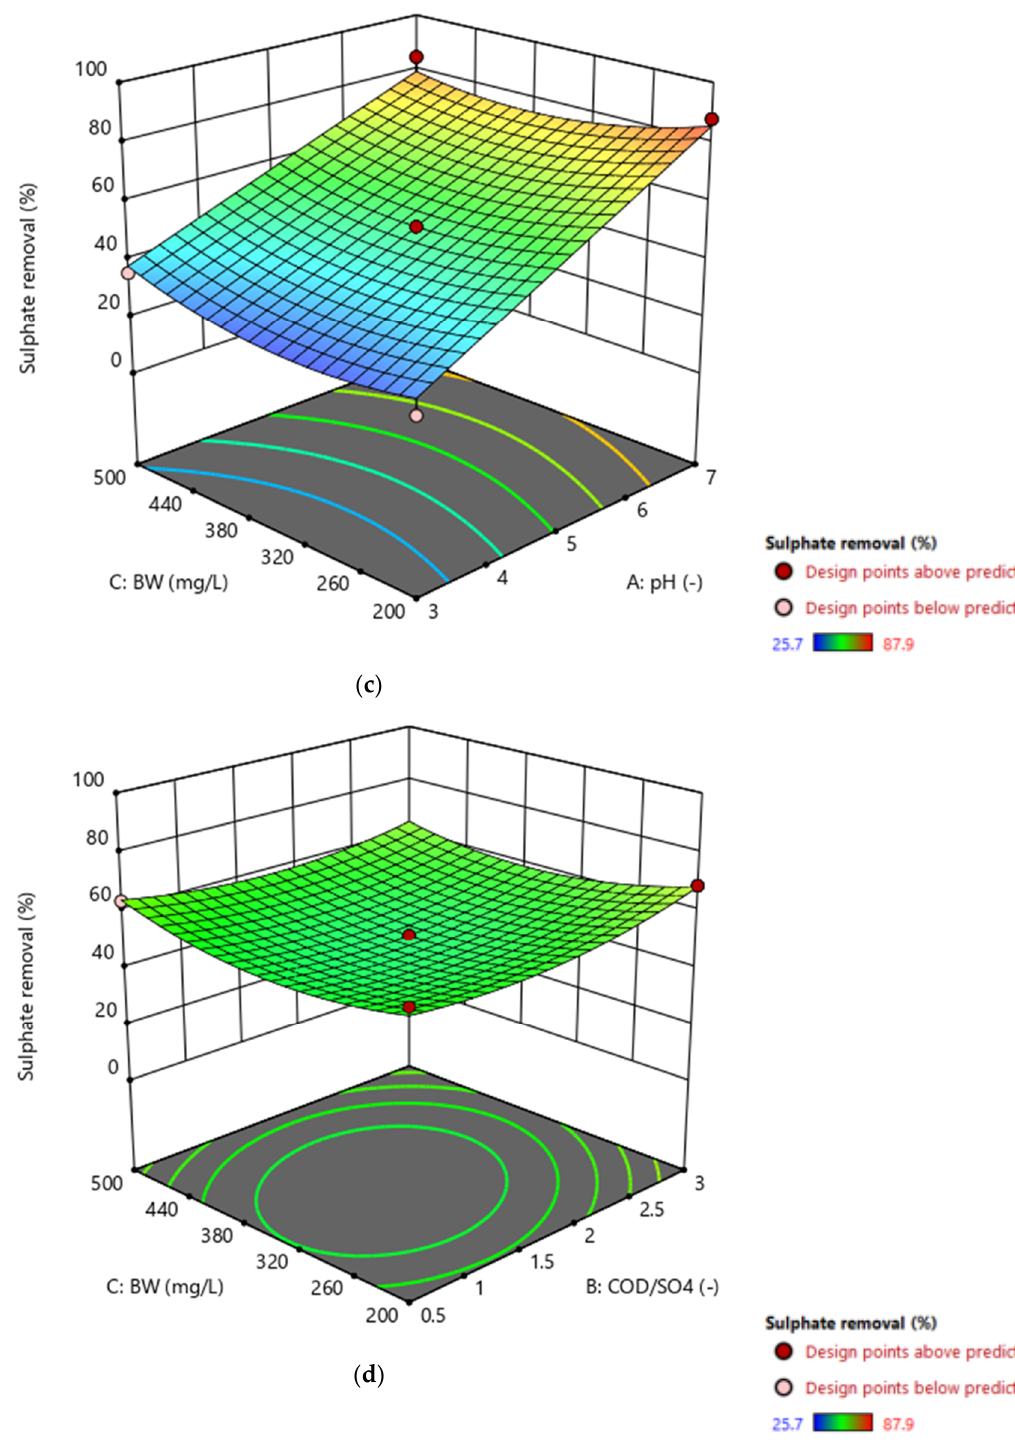
Figure 4. Perturbation of factors as a function of coded values ( a ) and 3-D plots ( b – d ) showing the effect of independent variables on sulphate removal.